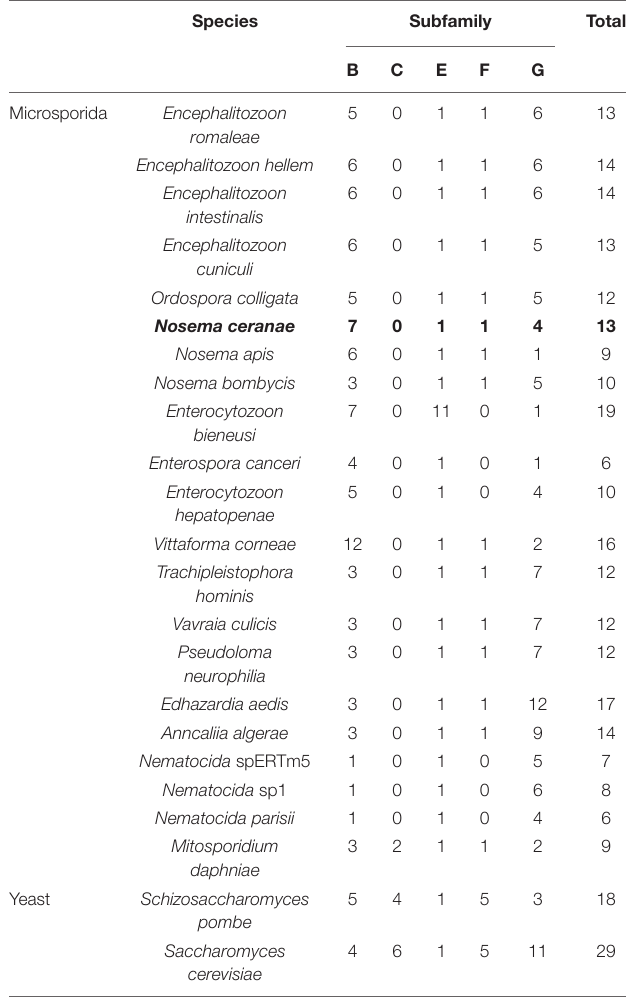
TABLE 2 | Numbers of ABC transporter genes in 22 microsporidian species and two yeast species, in each of five subfamilies. Species